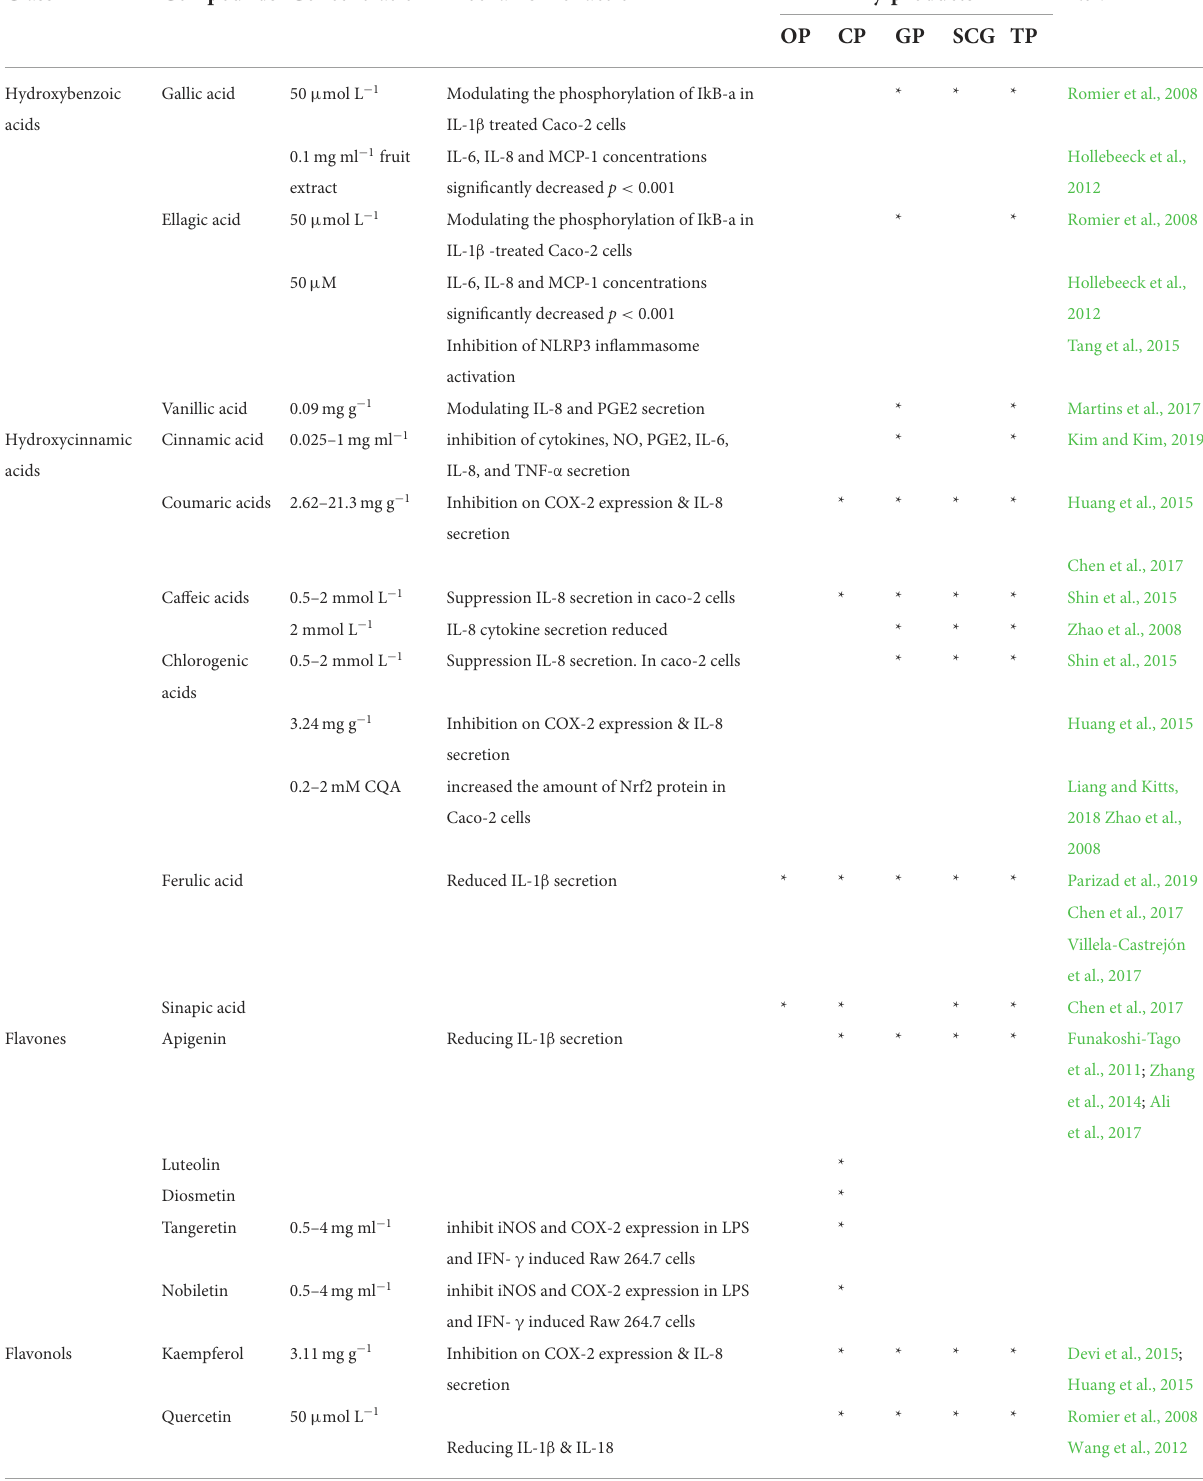
TABLE 4 Different class of phenolic compounds and their mechanism of action.